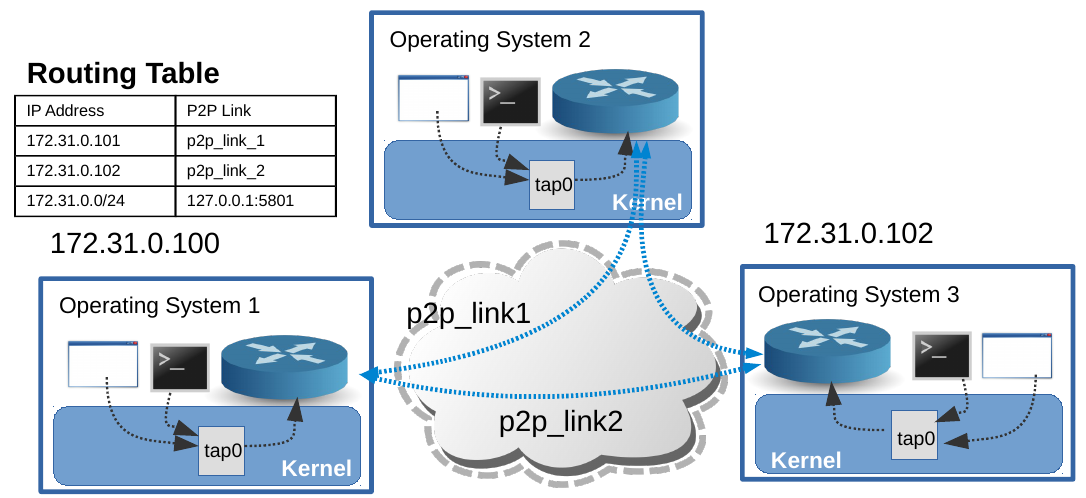
Figure 2. Applications Communication through TinCan